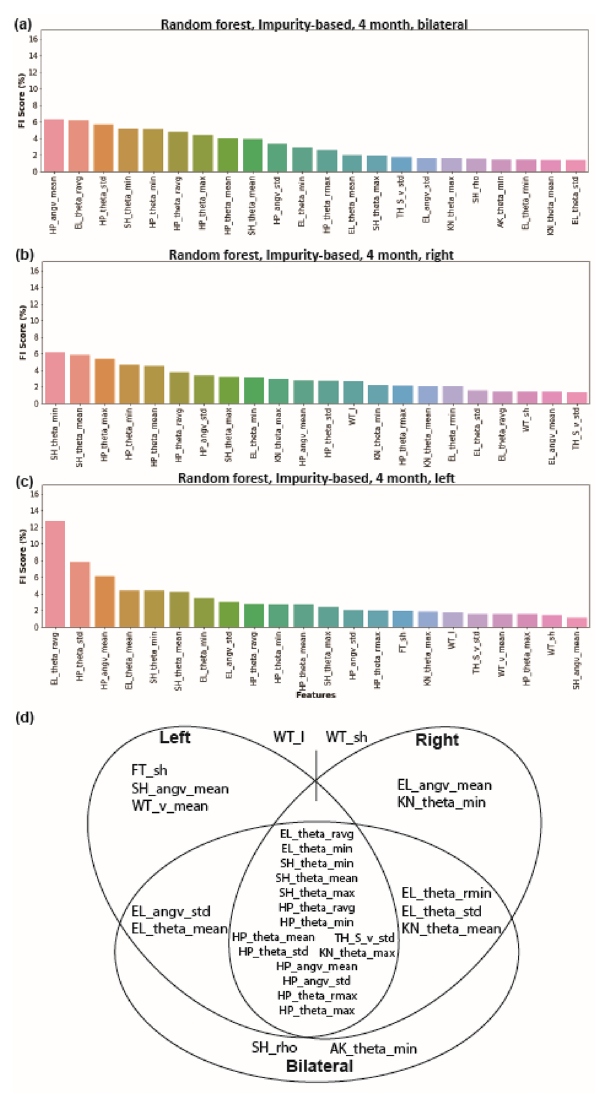
Figure 3. Left- and right-side-only datasets yield different rankings of feature importance score, while still sharing the majority features in the 4mon J20 mice. Bilateral and unilateral Feature Importance (FI) scores (%) calculated by the Random Forest feature importance method using the bilateral ( a ), right-side-only ( b ), and left- side-only ( c ) datasets. The 22 highest-ranked features, which made the largest contribution towards identifying genotype and age are shown. ( d ) A summary diagram of the 22 highest-ranked features of the left-side-only, right-side-only, and bilateral datasets indicating their common and unique features. Please see the feature definition equations for abbreviations used for each feature (Table 1). Panels generated through Python 3.7, MATLAB 9.2, and Adobe Illustrator